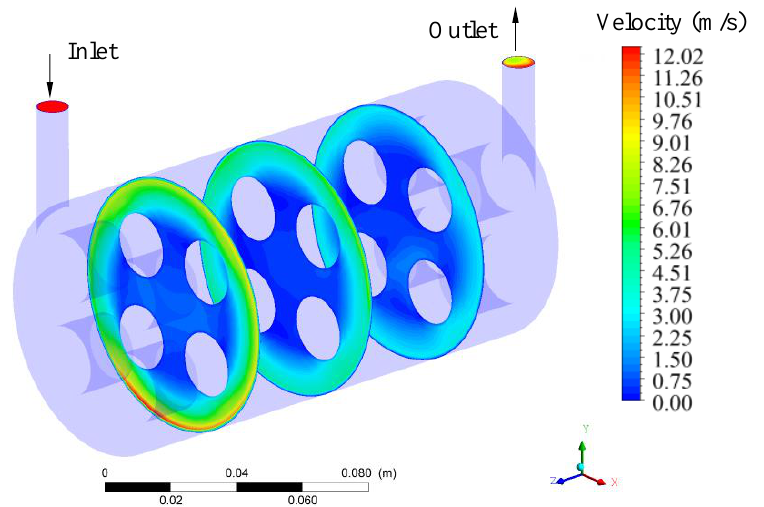
Figure 9. Velocity distribution of the fluid mixture inside the hull ot the filtration module during the water/oil separation process.